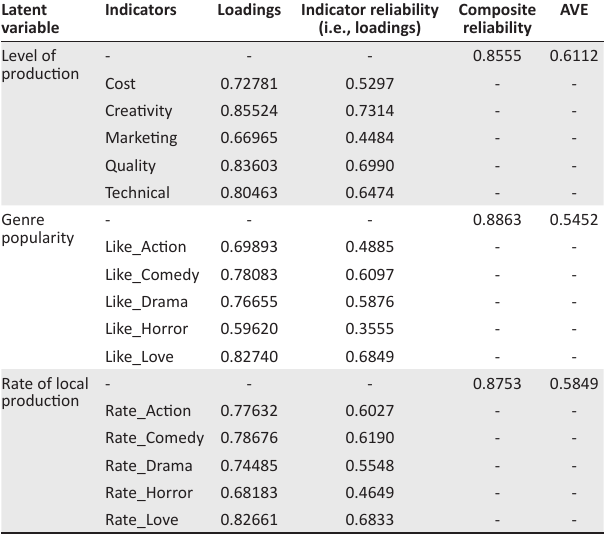
TABLE 2: Results summary for reflective outer models.